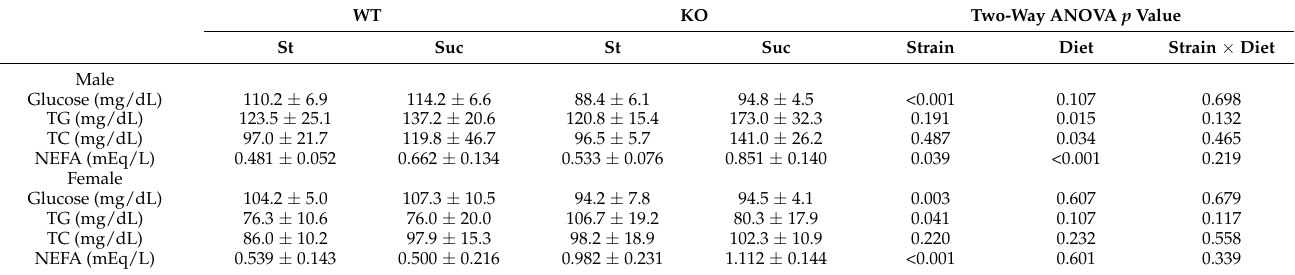
Table 4. Serum glucose, TG, TC and NEFA